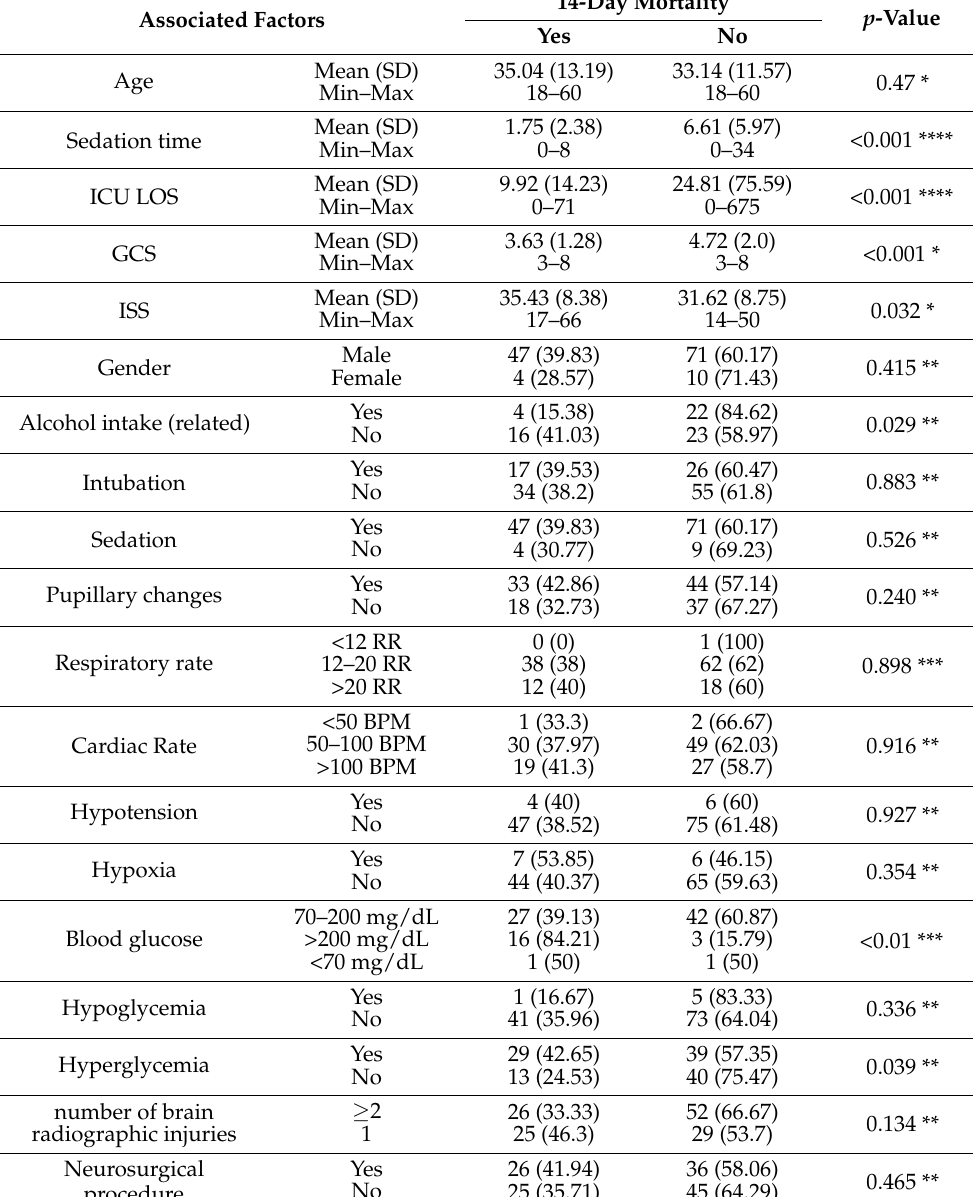
Table 4. Factors associated with 14-day mortality in severe TBI victims with focal